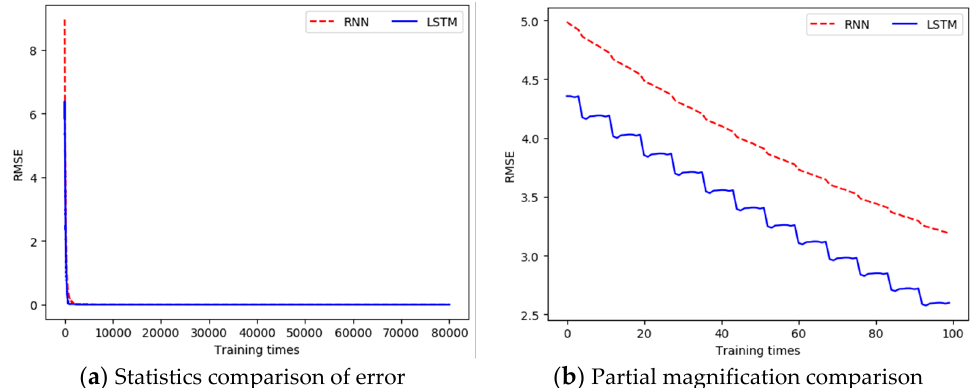
Table 2. Records of MAE, RMSE, and MAPE when training time reached specific value.